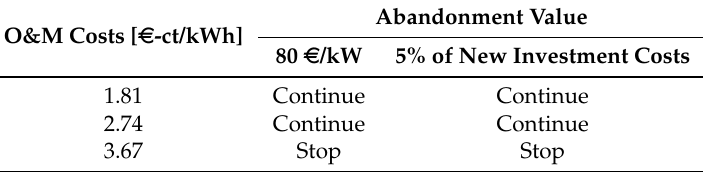
Table 3. Optimal decision regarding the further operation in the next five years of all onshore wind power plants analyzed after EEG levy expiration and regarding different levels of O&M costs and abandonment values (see Table